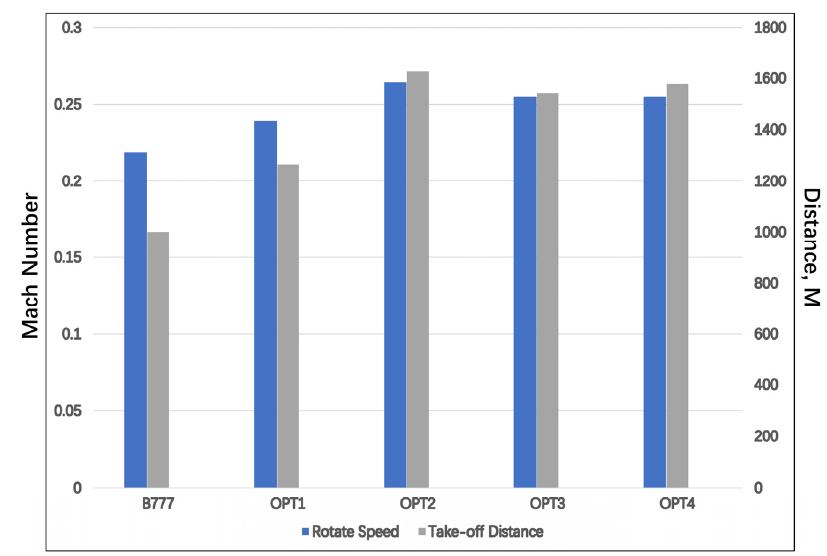
Figure 11. Takeoff performance for the four configurations.